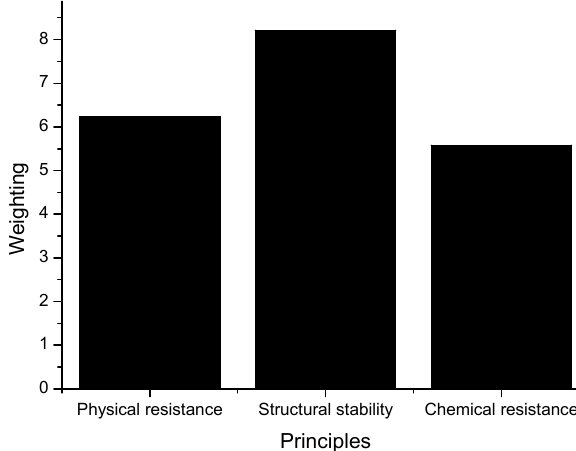
Figure 7. Ranking of different grouped repairing principles.